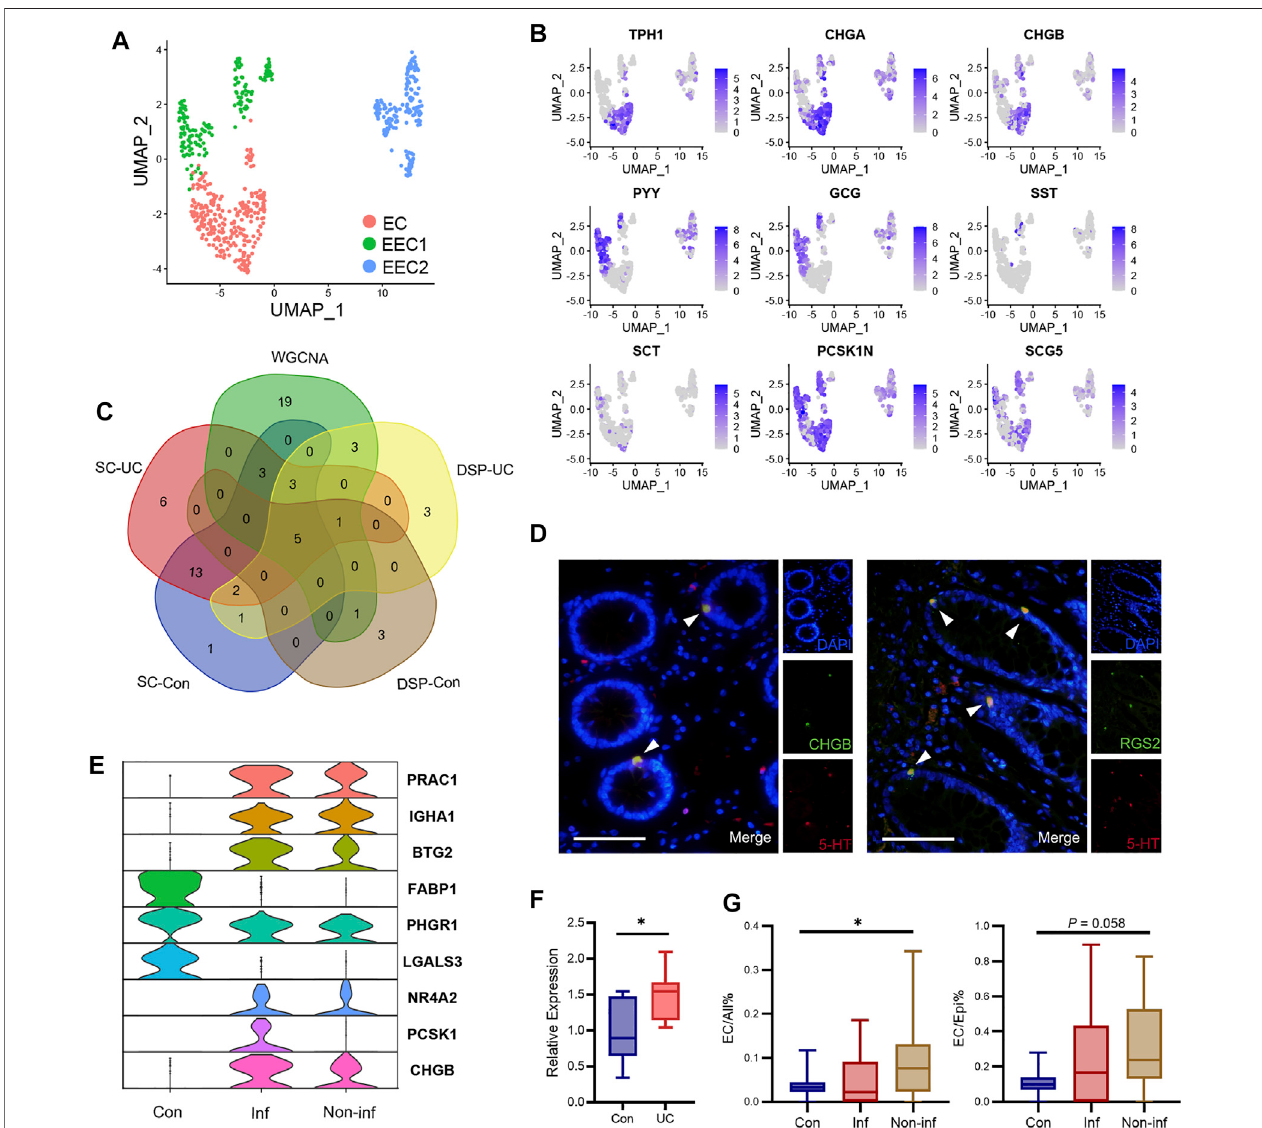
FIGURE6| Datavalidationusingsingle-celltranscriptomicdataandimmuno fl uorescencestaining. (A) UMAP(UniformManifoldApproximationandProjection)plot of enteroendocrine cells, including 271 EC cells, 167 cells for the EEC1 group, and 166 cells for the EEC2 group. (B) Markers of enteroendocrine cells plotted on the UMAP plot. (C) Venn diagram of genes enriched in EC cells as determined by single-cell RNA-seq, genes enriched in EC cells as determined by DSP, and genes in the Green3 module associated with EC cells as identi fi ed by WGCNA. (D) Representative immuno fl uorescence staining of CHGB and RGS2 in colonoscopic biopsy samplesfrom healthyparticipants. The resultsindicatedasigni fi cantco-localization ofEC cells(5-HT positive), and CHGB and RGS2, respectively.Scalebar = 100 μ m; magni fi cation, ×400. (E) Violin plot ofDEGs between EC cells from the in fl amed mucosa ofpatients with UC and controls. Con, control. Inf, in fl amed mucosa of patients with UC. Non-inf, non-in fl amed mucosa of patients with UC. (F) The expression level of CHGB in patients with UC was con fi rmed by qRT-PCR. Differences between groups were analyzed using Student ’ s t -test (two-tailed). * p < 0.05. (G) Boxplot showing the ratios of EC cells to all cells (left) and to epithelial cells (right).